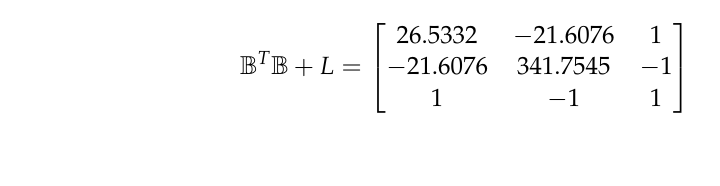
Figure 5. The chaos diagram of Chua’s system at initial condition x 0 = [ 5,1, − 3 ] T . It can be shown